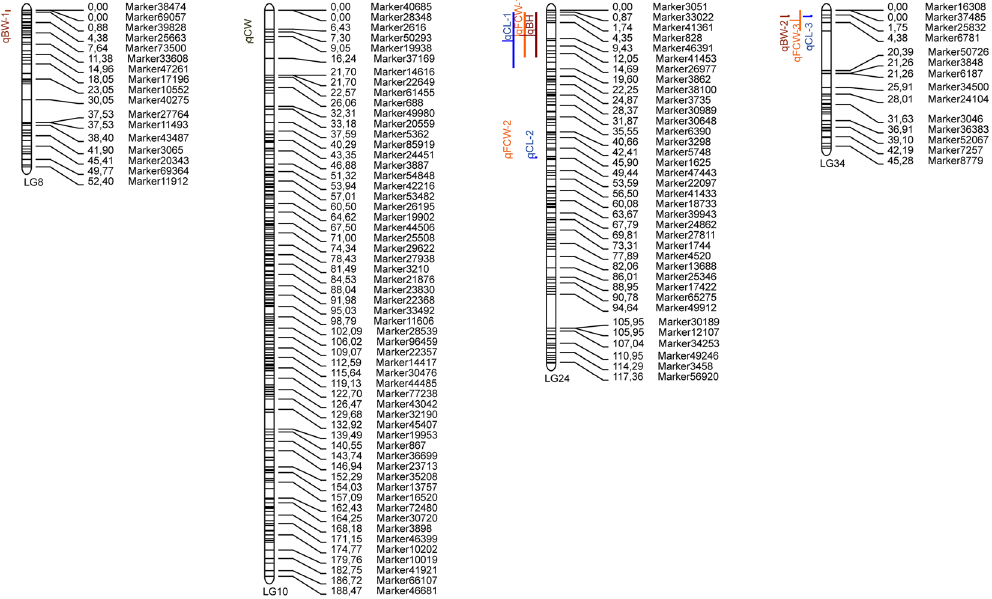
Figure 5. QTL mapping of growth traits. QTLs of different traits is represented by different colors.